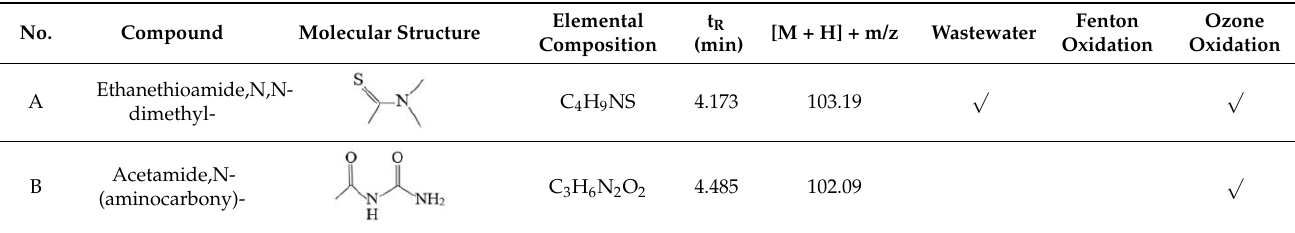
Figure 3. Effect of ozone flow rate on ( a ) COD removal; ( b ) B/C values; ( c ) BOD 5 variation during Fenton oxidation. Conditions are as follows: ozone concentration 1 g/L; 250 mL wastewater; pH = 6.26. A Table 2. GC – MS analysis of petrochemical wastewater.